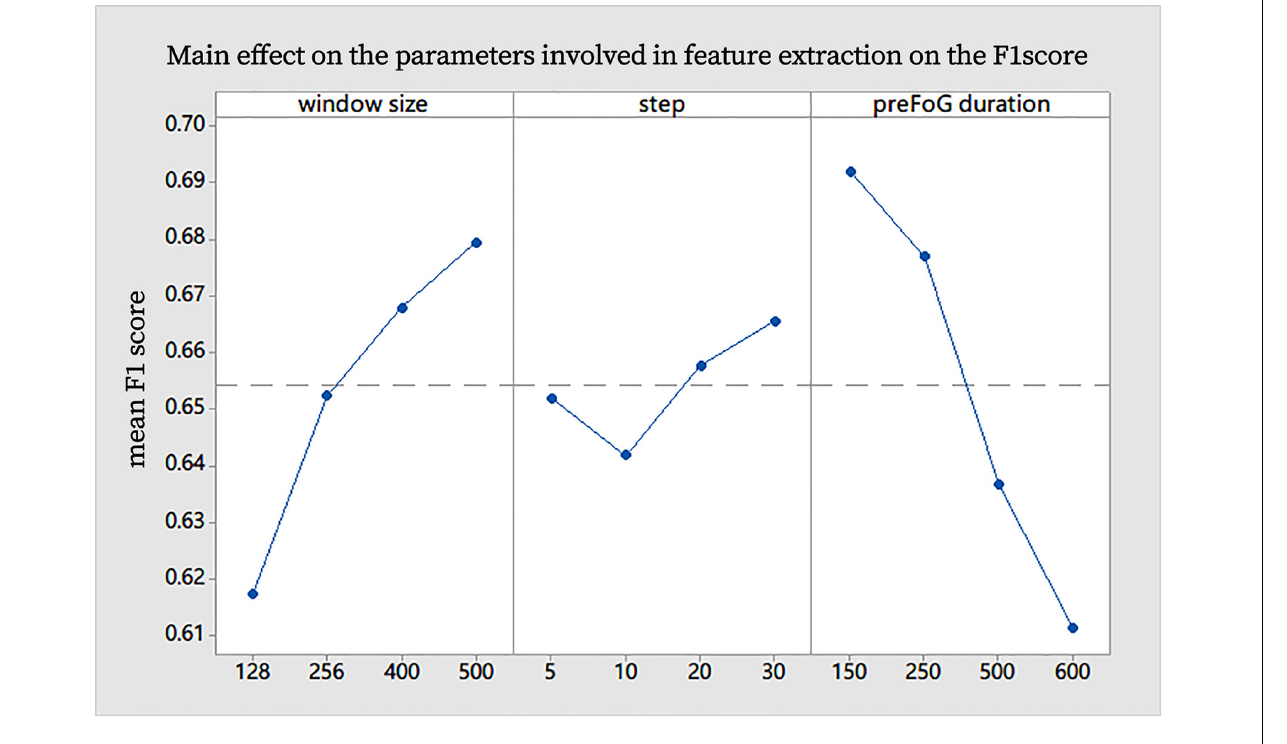
FIGURE 7 | Main effect on the parameters involved in feature extraction on the F1